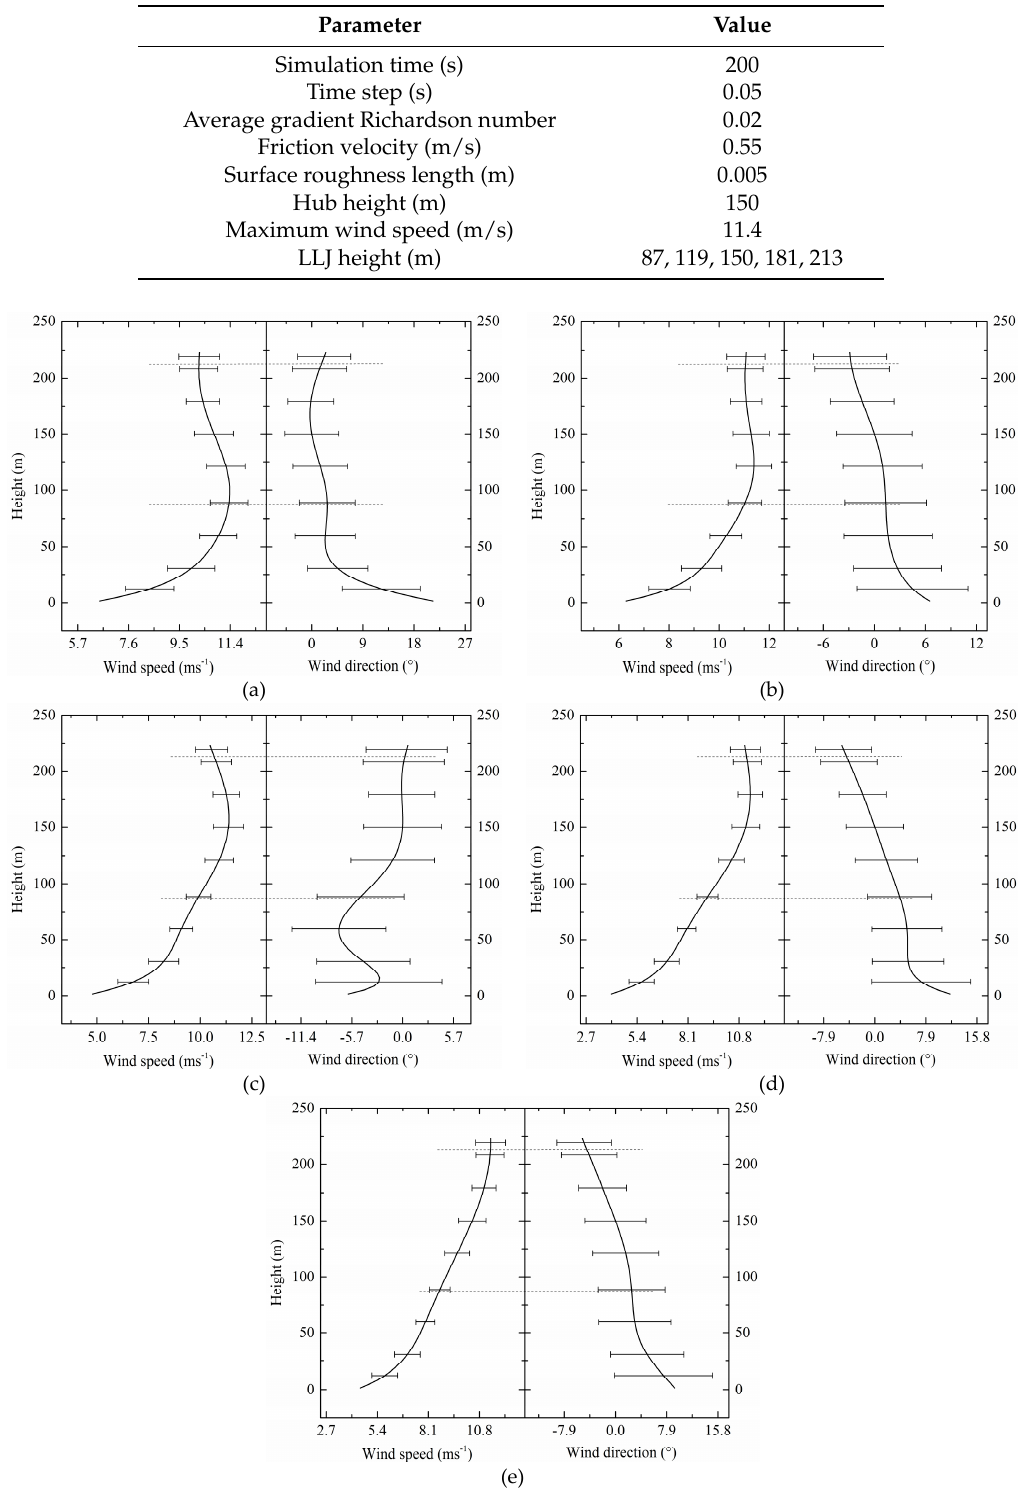
Table 1. The values of the main parameters in the GP_LLJ spectral model. GP_LLJ: Great Plains Low-Level Jet (LLJ).